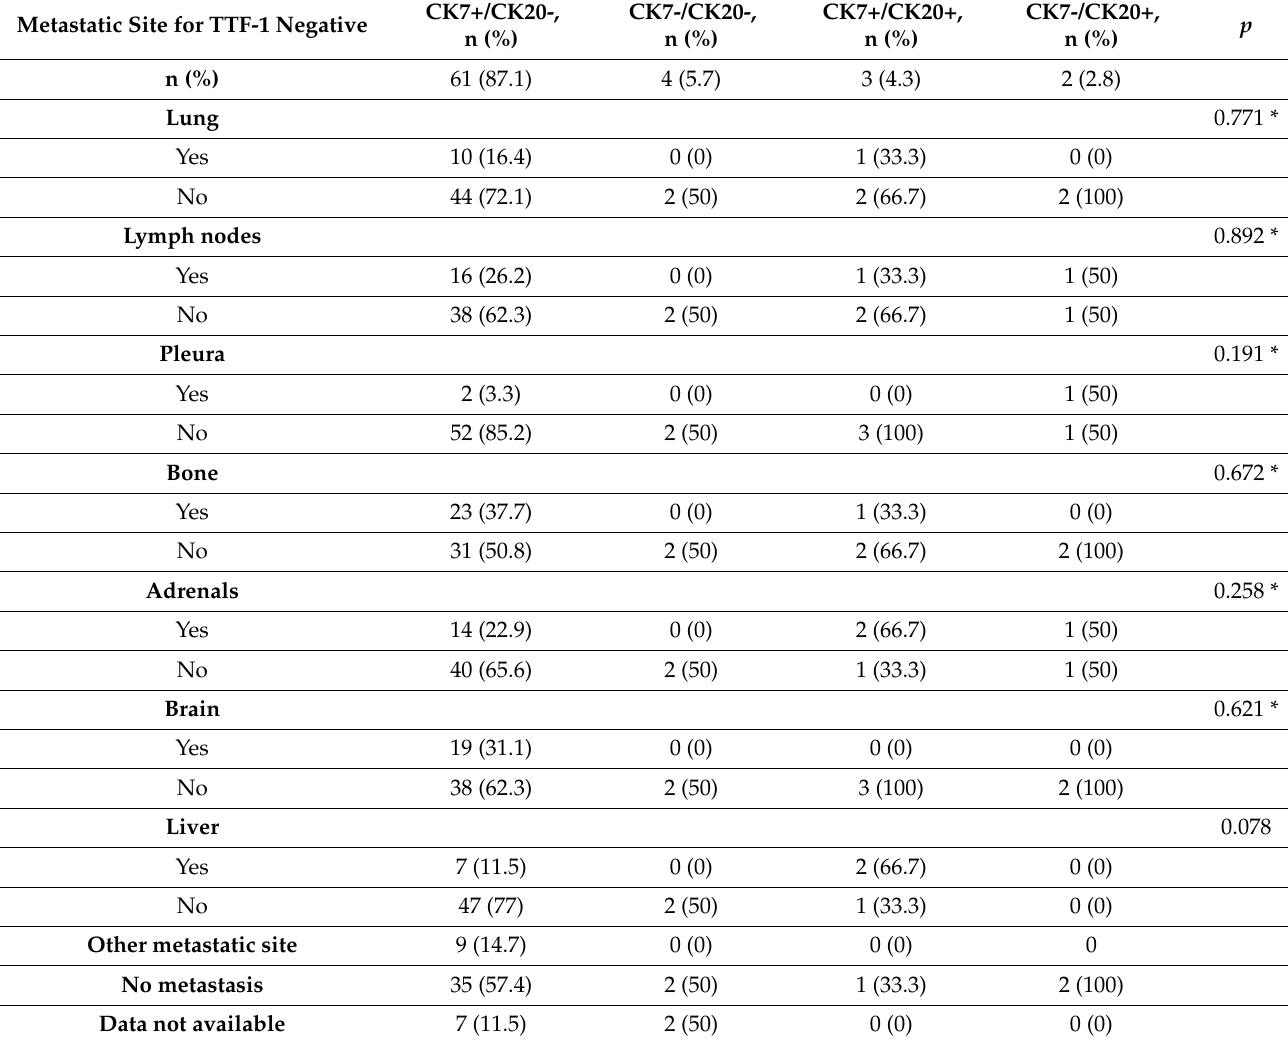
Table 3. Metastatic sites according to CK7/CK20 status in TTF-1 negative carcinomas. Metastatic Site for TTF-1 Negative